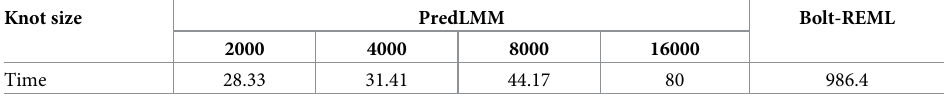
Table 2. Time comparison (in minutes) of PredLMM for varying different knot (sub-sample) sizes with Bolt- REML for Simulation Study (2.2) with 100k individuals.